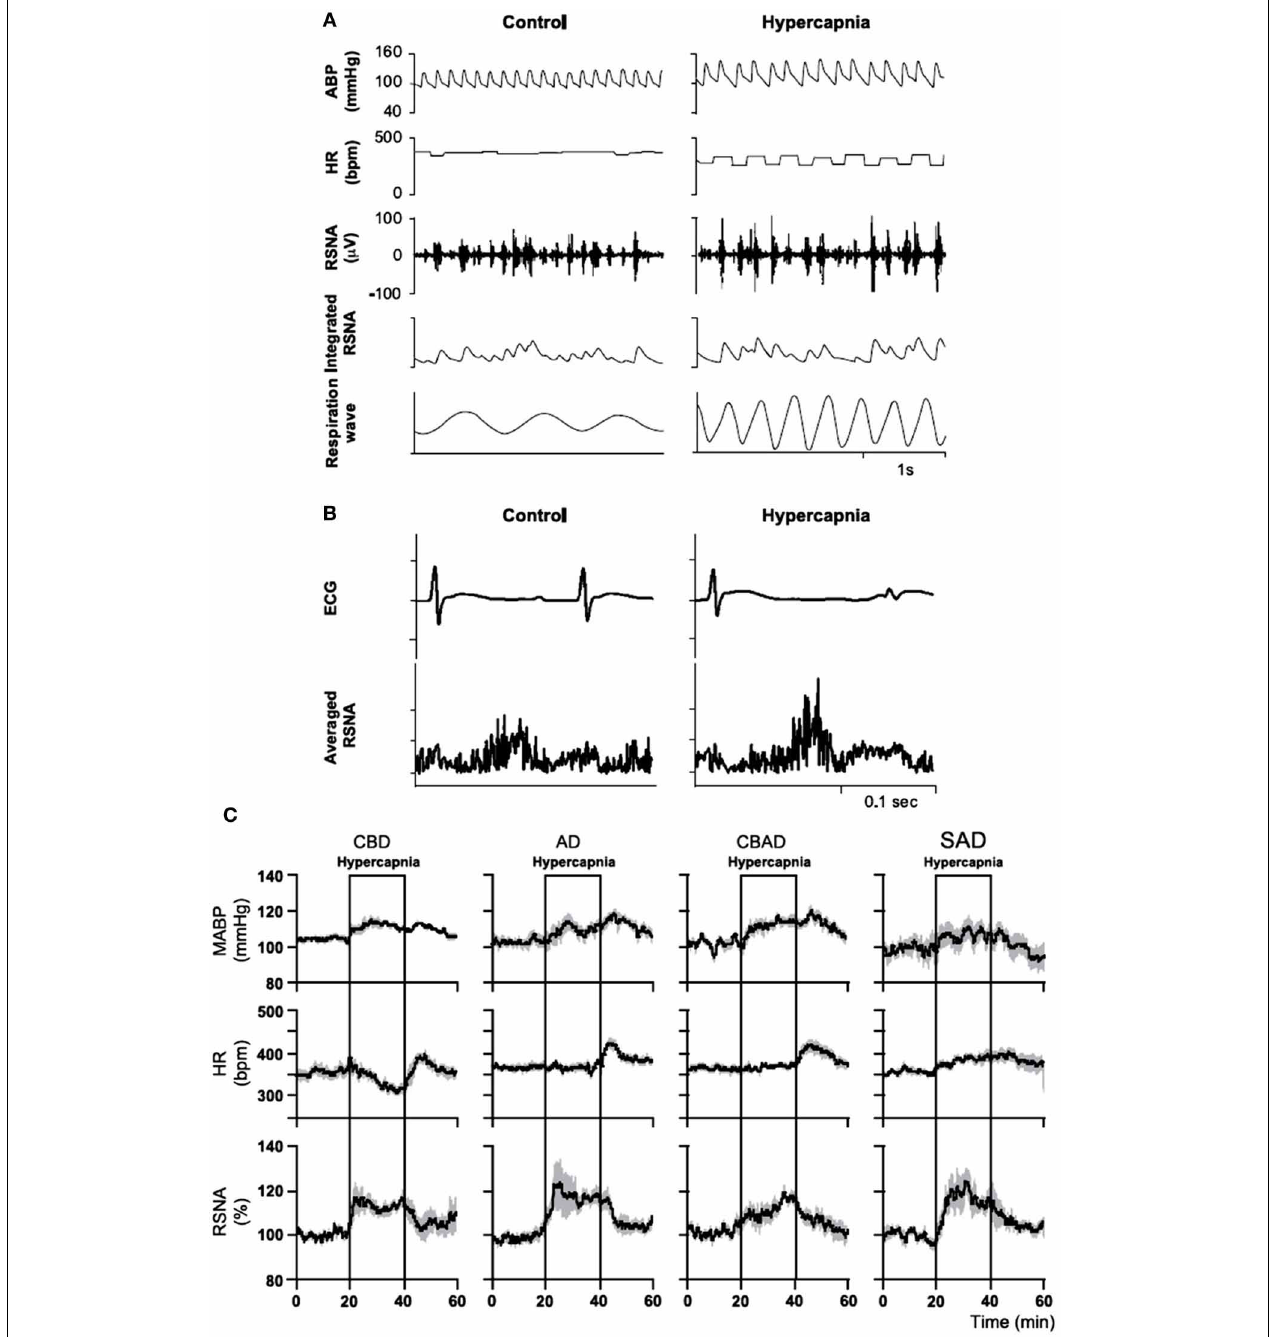
FIGURE 12 | In conscious rats, hypercapnia increases arterial blood pressure (ABP) and renal sympathetic nerve activity (RSNA). Hypercapnia increased mean ABP [from 105 to 117mm Hg; (A) ], RSNA [from 100 to 115%, (A,B) ], and the respiratory rate [from 63 to 151 breaths/min; (A) ], but decreased HR [from 374 to 302 beats/min; (A,B) ]. Hypercapnia significantly increased mean ABP and RSNA in intact (A) ,